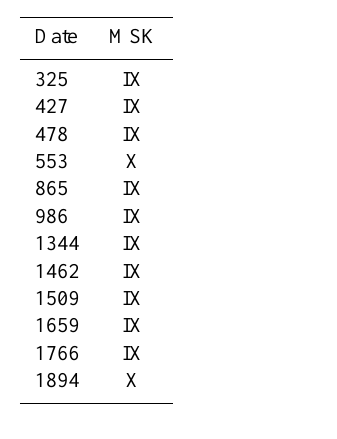
Table 1. Disastrous earthquakes around Istanbul from 325 to 1894 (Istanbul Earthquake Symposium, 1991).